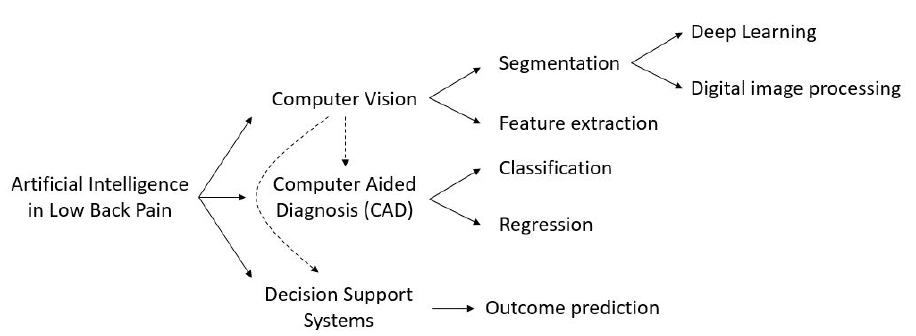
Figure 1. Schematic partitioning of the works concerning the application of AI in